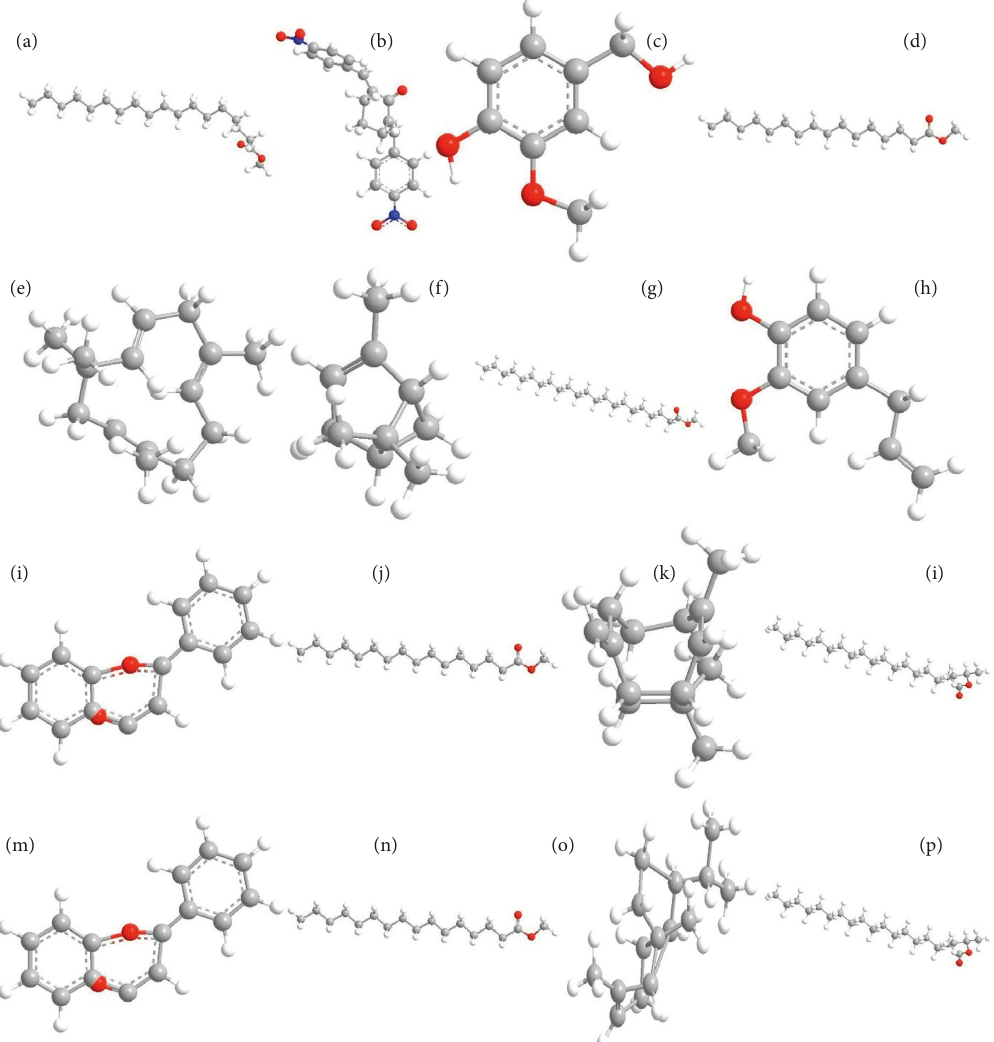
Figure 2: Bioactive compounds of polyherbal ethanolic extract (a) (Z)-13-Octadecen1-yl acetate, (b)2,6-Bis[3-nitrobenzylidine]-4- methylcyclohexanone, (c) 4-hydroxy-3-methoxy benzyl alcohol, (d) 8-octadecenoic acid, methyl ester, (e) A-caryophyllene, (f) A-pinene, (g)docosanoic acid, methyl ester, (h)eugenol, (i)flavone, (j)hexadecanoic acid, ethyl ester, (k)humulene-v1,(l) isopropyl stearate, (m) phenol,2,4-Bis[1,1-dimethylethyl], (n)n-hexadecanoic acid, (o)Trans-A-copaene, and (p) tetra decanoic acid, propyl